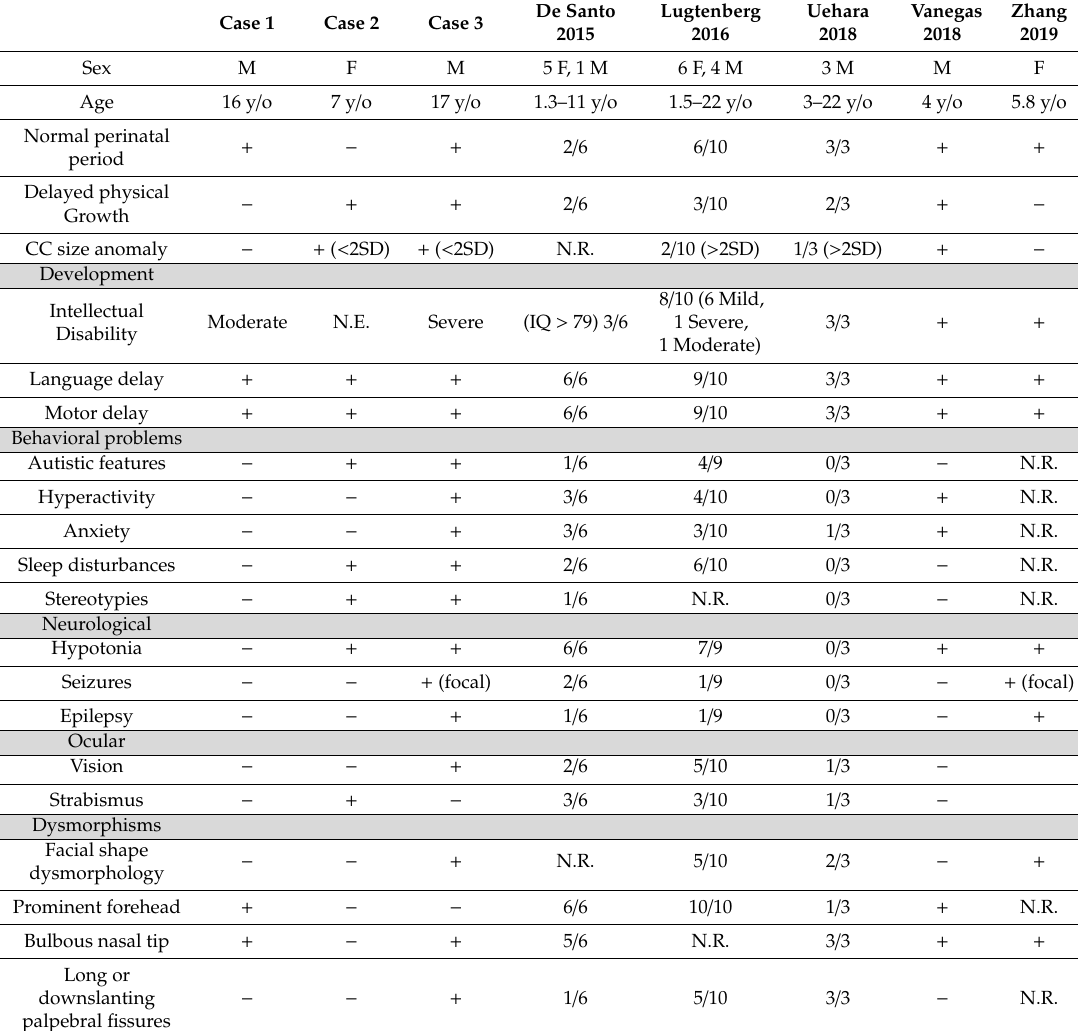
Table 1. Clinical features of our WAC cases compared to individuals reported in